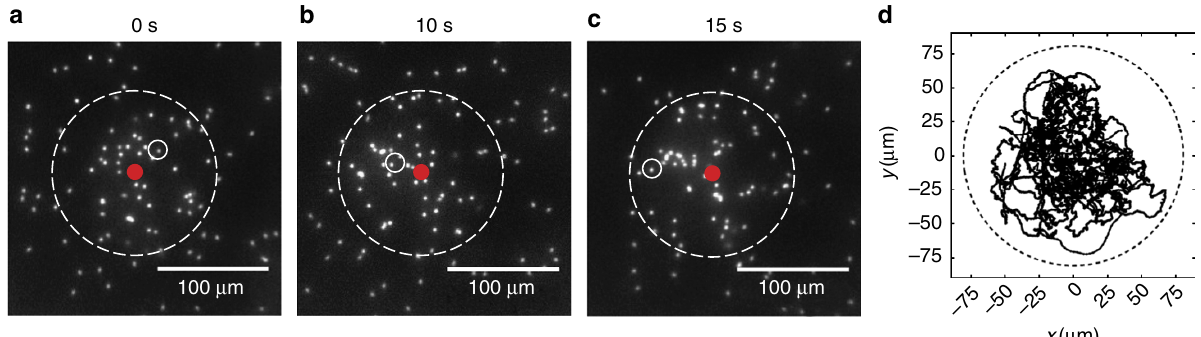
Figure 1 | Active Janus particles in a weak acoustic trap. ( a – c ) Snapshots of 2 m m swimmers in an acoustic trap. The solid red spot indicates the trap centre and the dashed white circle delineates the outer edge of the well. The swimmer shown inside the solid white circle undergoes active Brownian motion while exploring the confines of the trap. ( d ) Two-dimensional trajectories of several particles inside